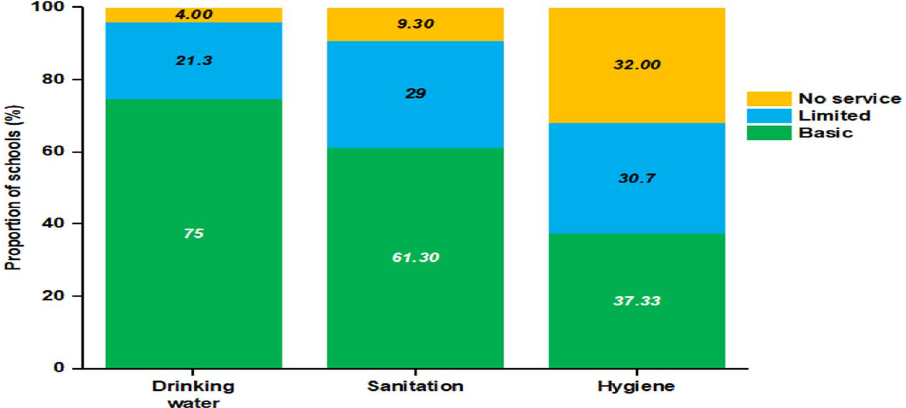
Fig. 1 Access to basic WASH services among school facili- ties of Bishoftu Town,